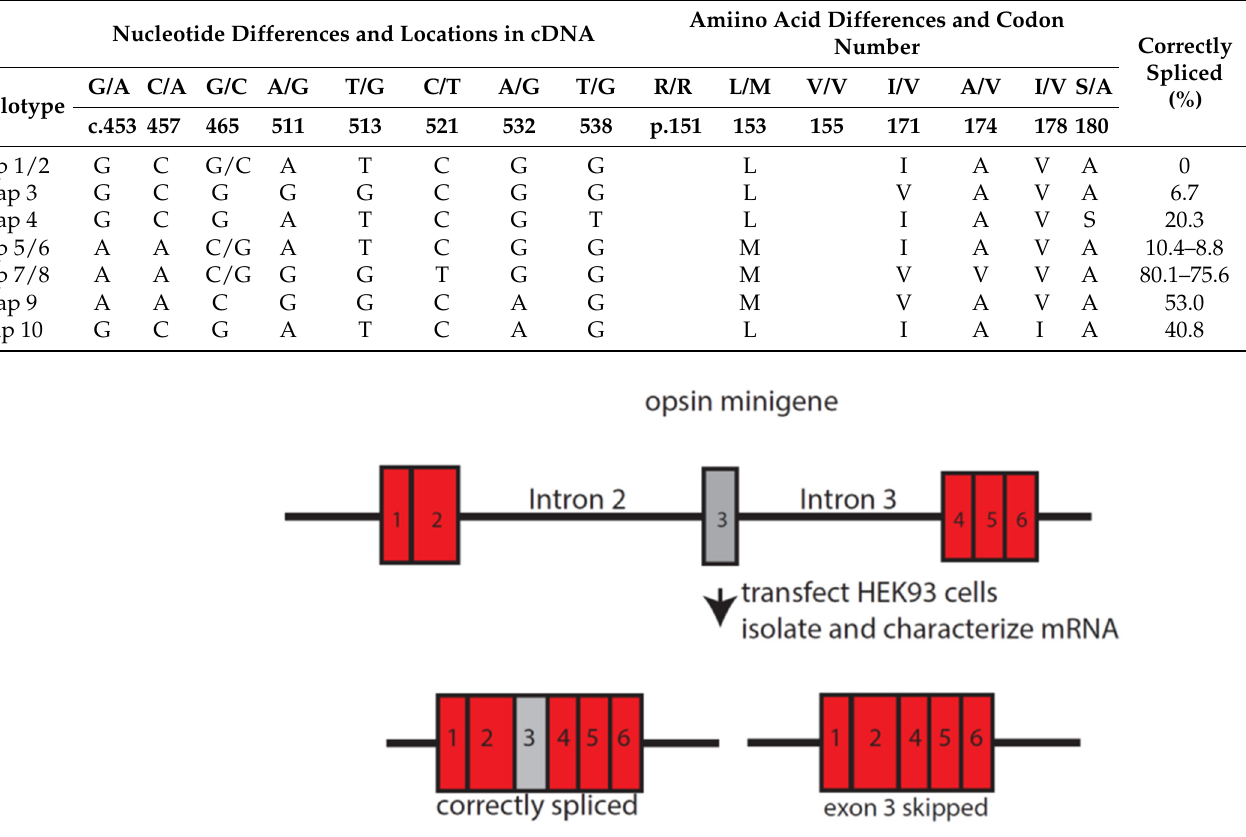
Figure 1. Opsin minigene splicing assay. Top: The OPN1LW minigene is OPN1LW cDNA with introns 2 and 3 inserted. The introns are labeled, and the numbered red rectangles are the exons that were identical in sequence for all minigenes. The gray rectangle is exon 3, which varied in sequence among the minigenes. The effects of different SNP combinations in exon 3 on splicing were measured by first transfecting HEK293 cells with minigenes. mRNA was isolated from HEK293 cells, and the amount of correctly spliced mRNA was quantified. Data in Table 2 are from reference [22], and the percentage of correctly spliced mRNA was measured using capillary gel electrophoresis.